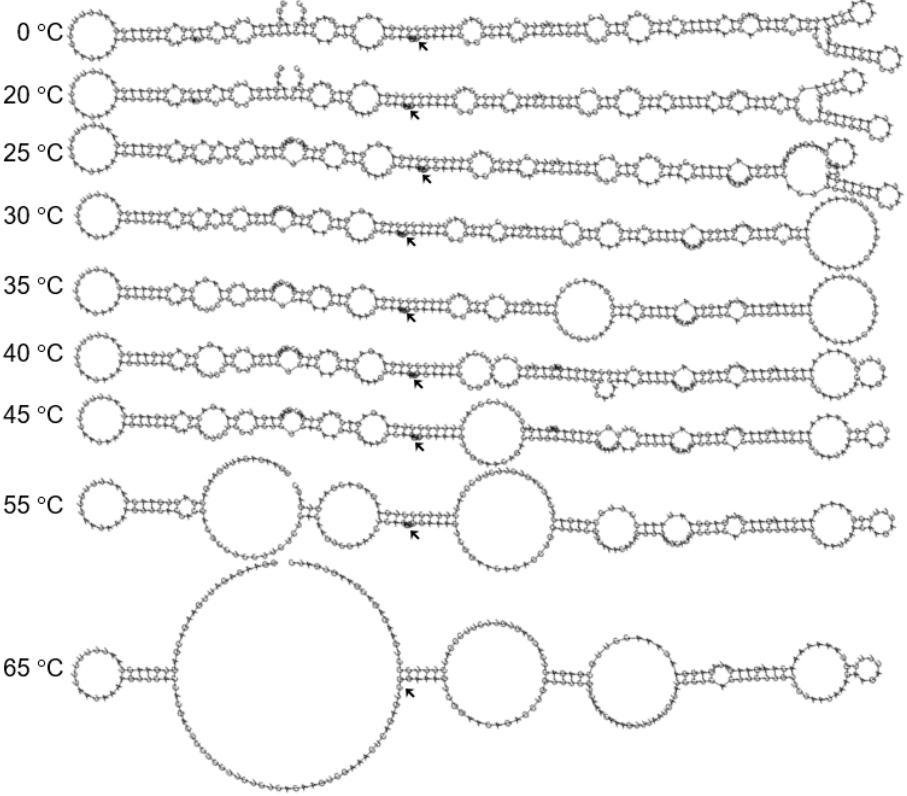
Figure 5. Centroid secondary structures of ASBVd(–) at different temperatures as determined using the RNAfold WebServer. Arrows denote C86, the cleavage site.